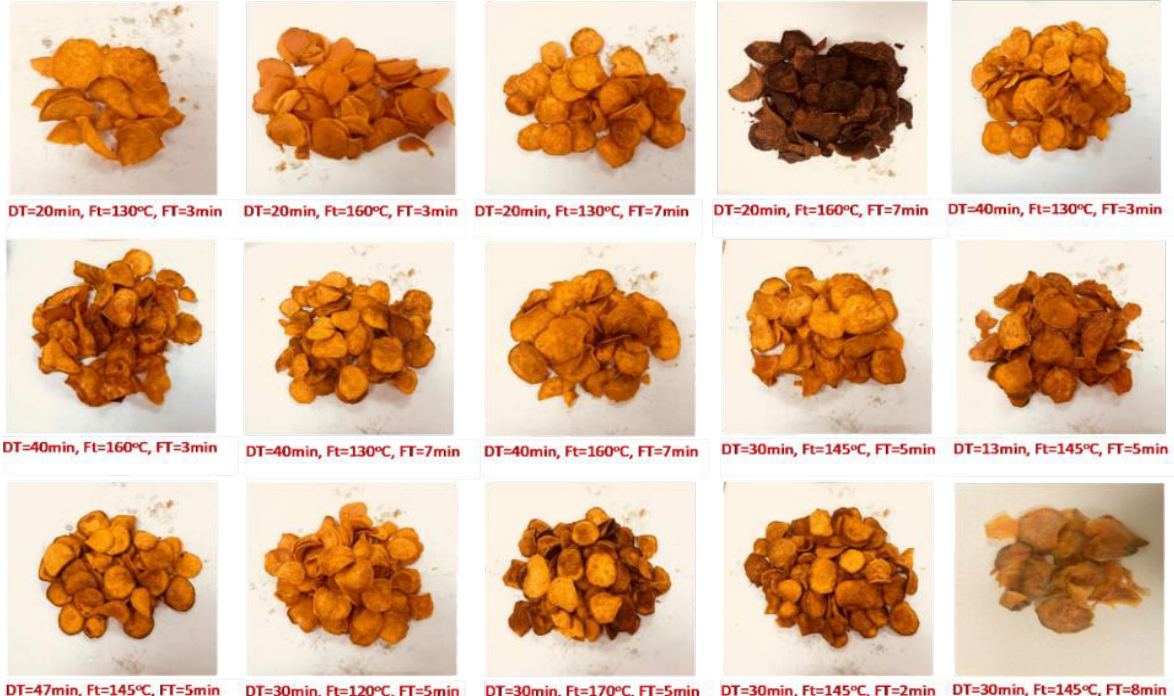
Figure 2 : Effect of frying conditions (15 conditions in a combination of pre-drying, frying temperature and frying time) on the quality of sweet potato chips